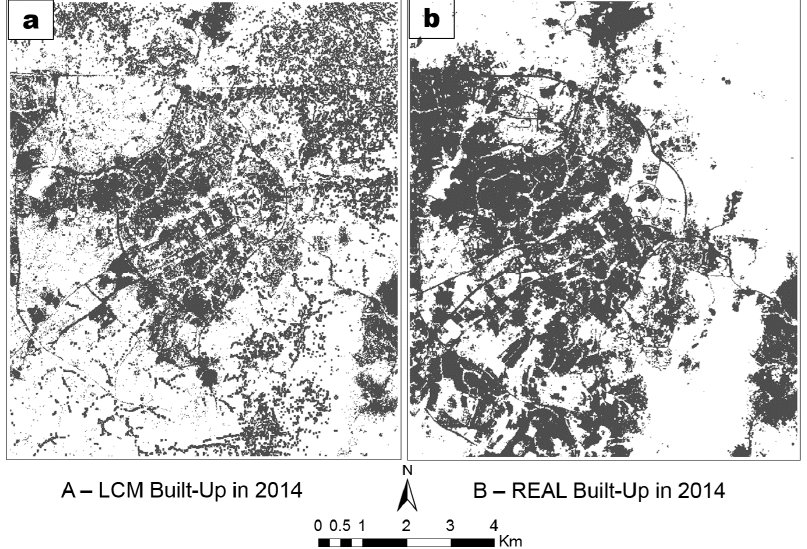
Figure 6. ( a ) LCM built-up; ( b ) Actual built-up footprint.